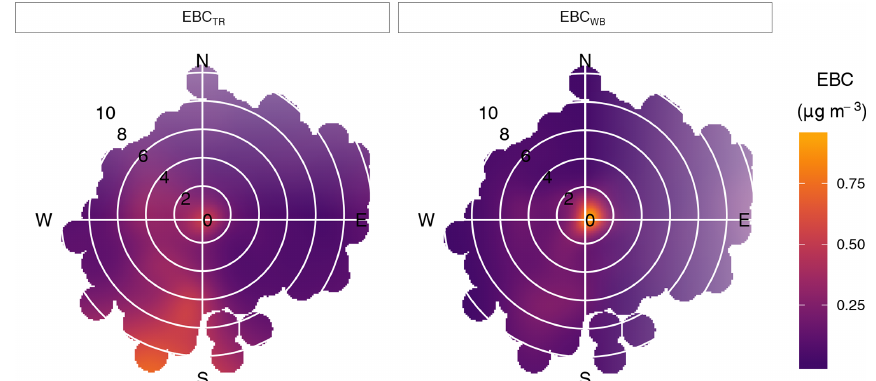
Figure 6. Mean polar plots of equivalent black carbon (EBC) components for Magadino-Cadenazzo between 2011 and 2018. Fill colours show EBC concentrations by wind speed (ms − 1 ) and wind